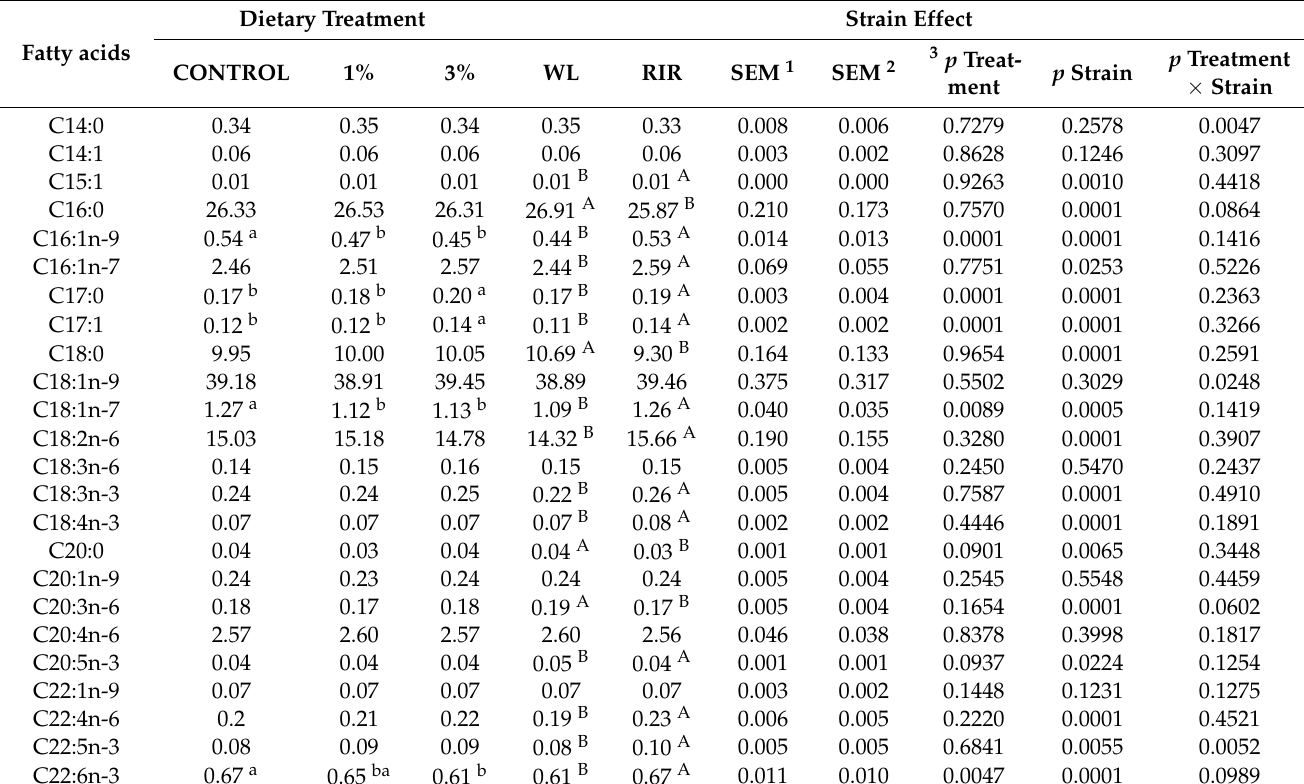
Table 5. Effect of dietary spirulina and strain of laying hens (White Leghorn: WL or Rhode Island Red: RIR) on the fatty acid profile (g/100 g total fatty acids) of yolk.